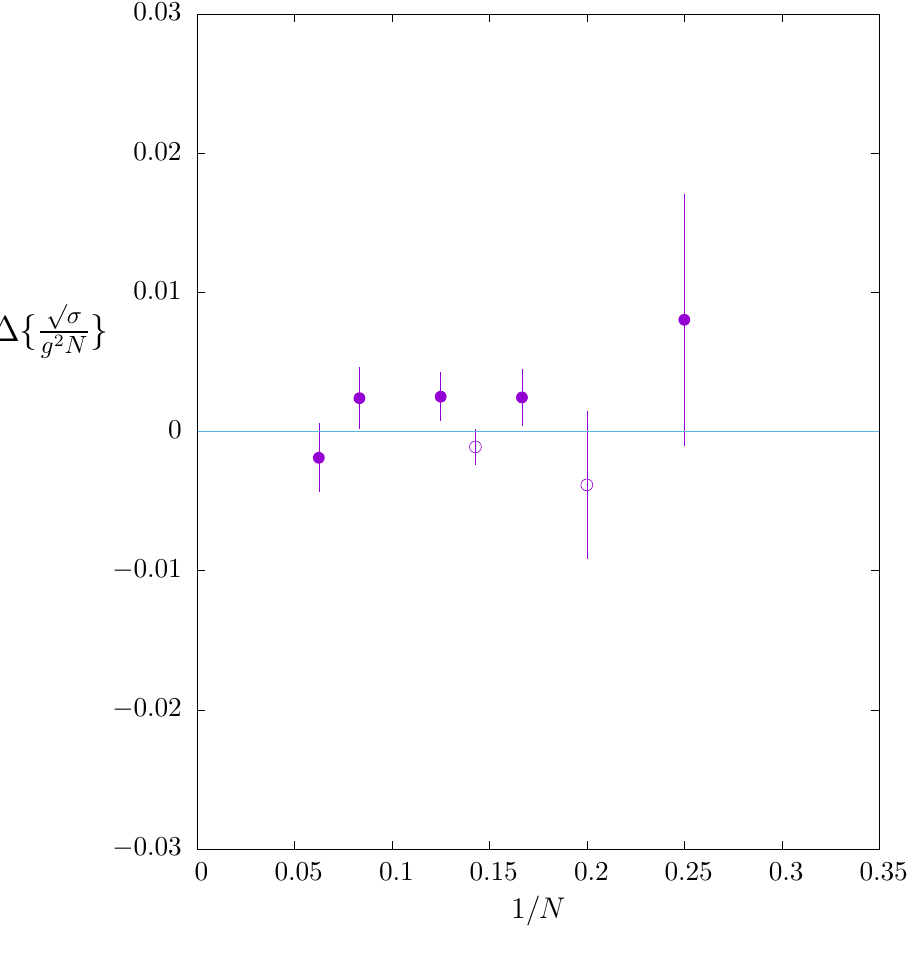
p Figure 23 . Di(cid:11)erence between value of (cid:27)=g 2 N and the best (cid:12)t in eq. (5.2), normalised by its value. Open points are N odd, full points are N even. (SO(3) is o(cid:11) the plot.) and imposing g 2 j = 4 g 2 j from eq. (2.9), we obtain the prediction for SU(2) su2 su2 a f